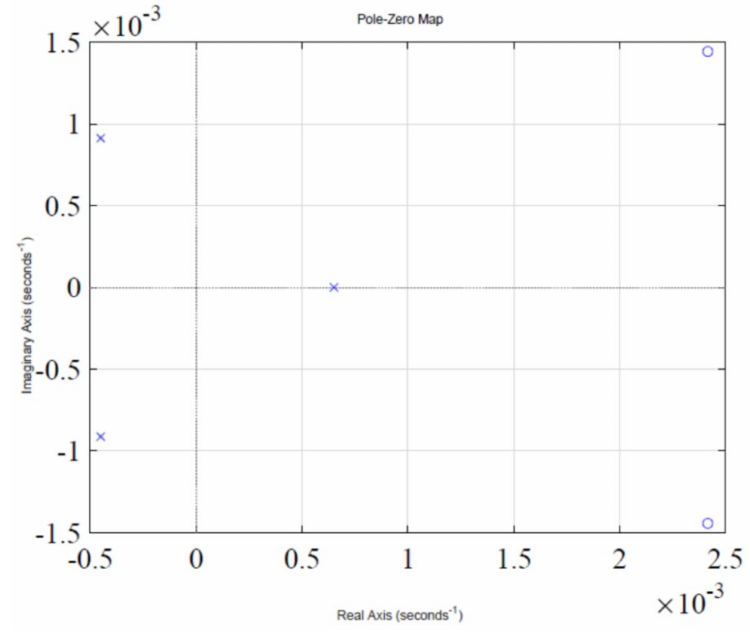
Figure 3. Pole-zero plot of the